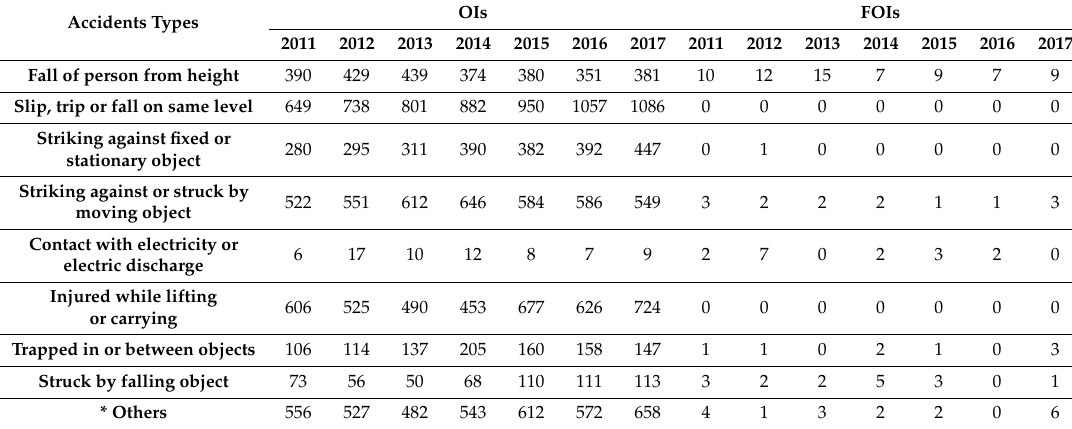
Table 2. The overview of the occupational injuries (OIs) and fatal occupational injuries (FOIs) among Hong Kong construction workers during the study